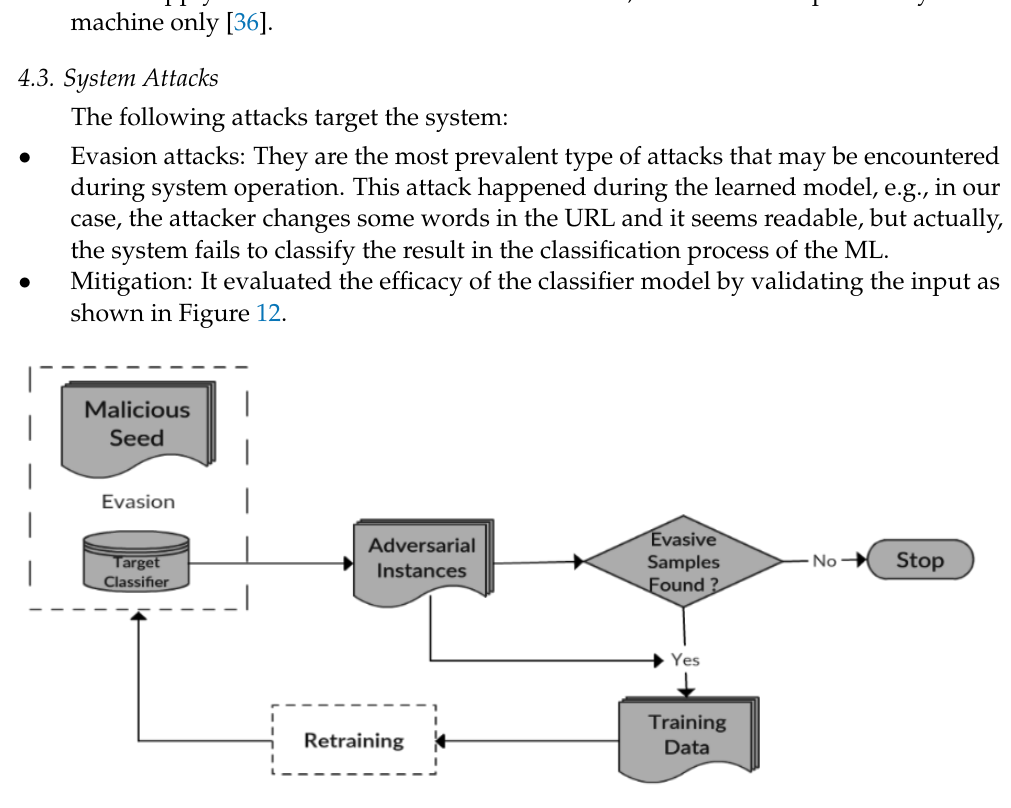
Figure 12. Retraining